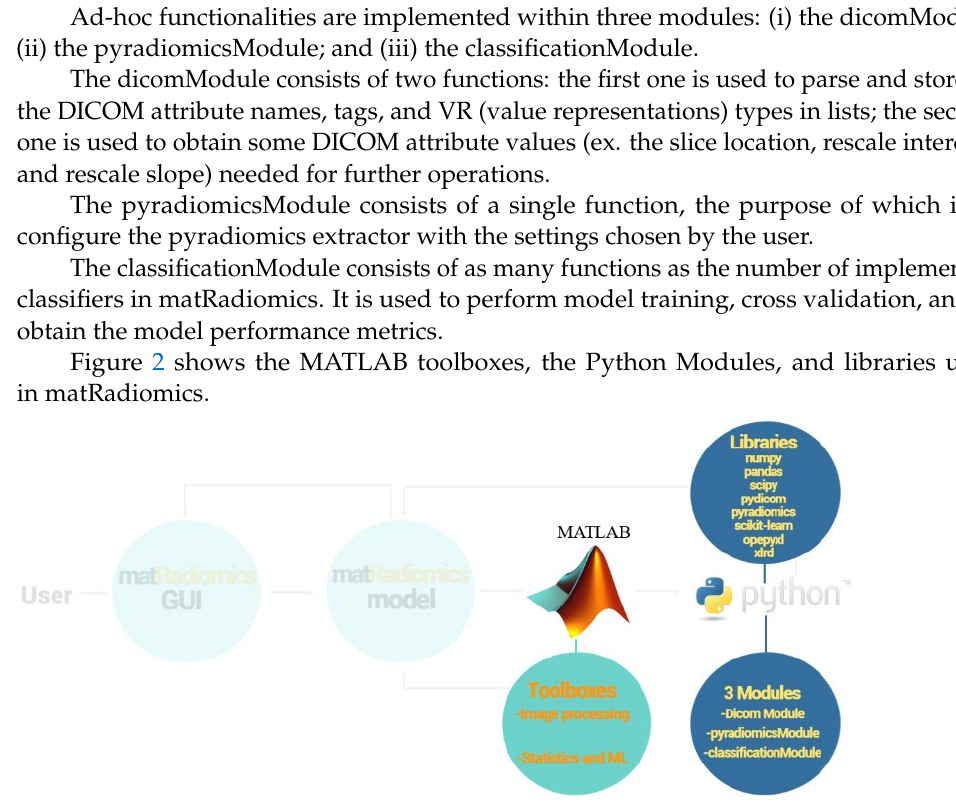
Figure 1. matRadiomics Architecture.